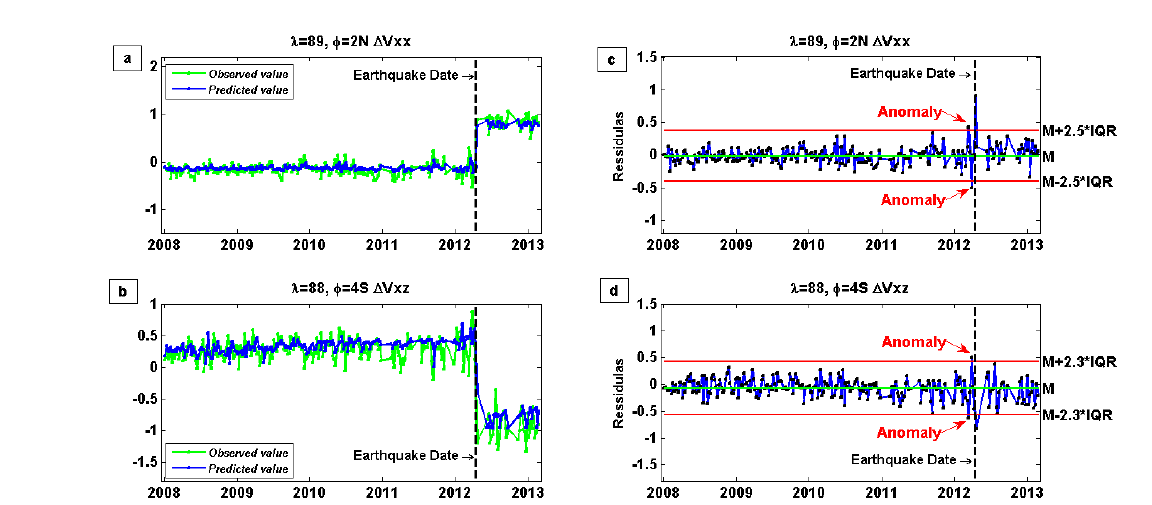
Figure 12. Same as Figure 6 but for Indian earthquake.